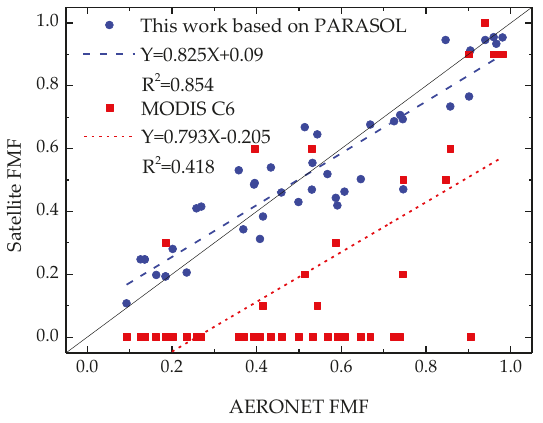
356 Fig. 7. The scatterplot of PARASOL and MODIS FMFs versus AERONET FMFs at the Beijing and Xianghe Figure 7. The scatterplot of satellite FMFs versus AERONET FMFs at the Beijing and Xianghe sites. 357 sites. AERONET refers to Aerosol Robotic